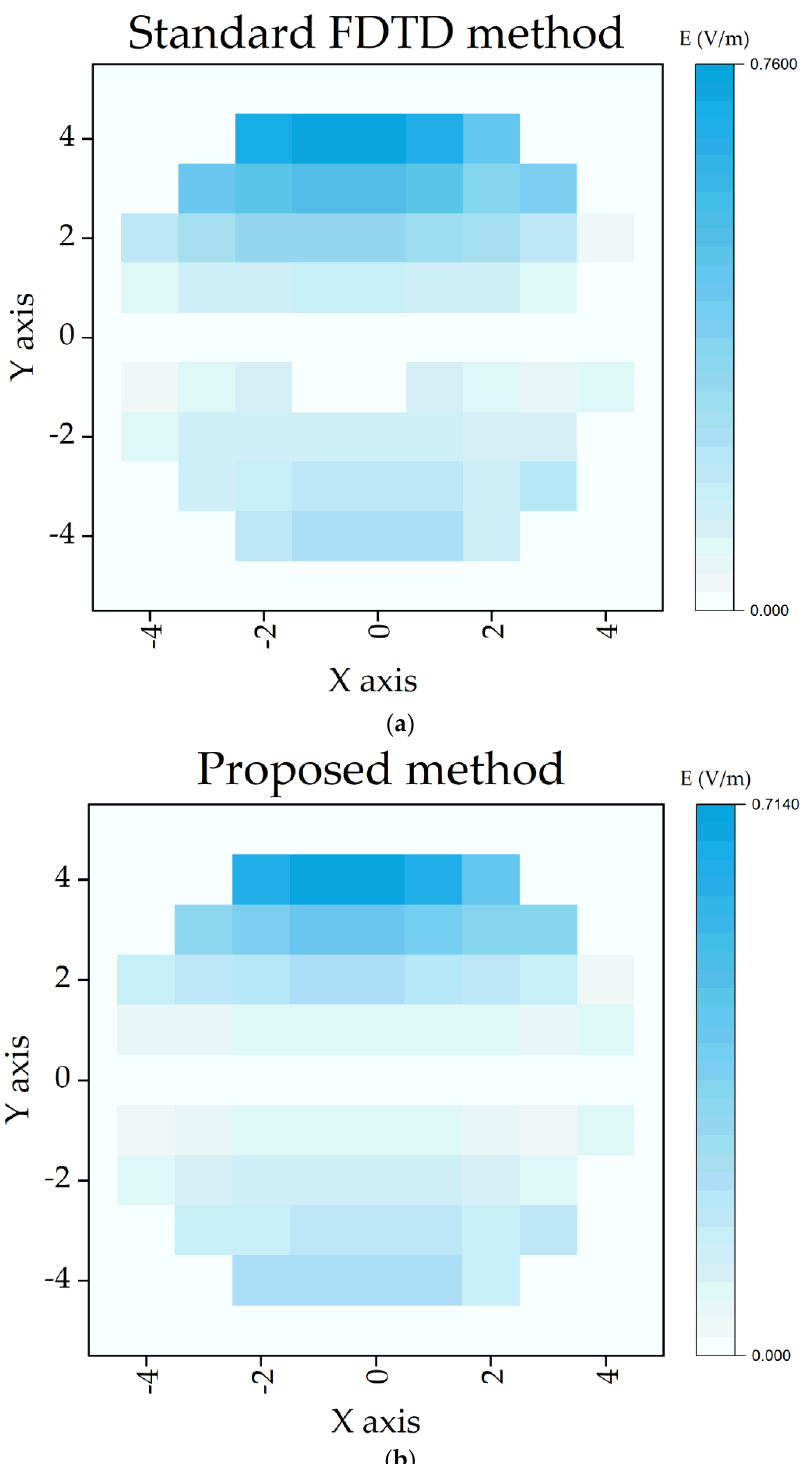
Figure 7. Induced electric field distribution in the plane z = 0 from Hertzian magnetic dipole: ( a ) Standard FDTD method, ( b ) Proposed method. Table 2. Induced electric field comparisons from Hertzian dipole excitation.